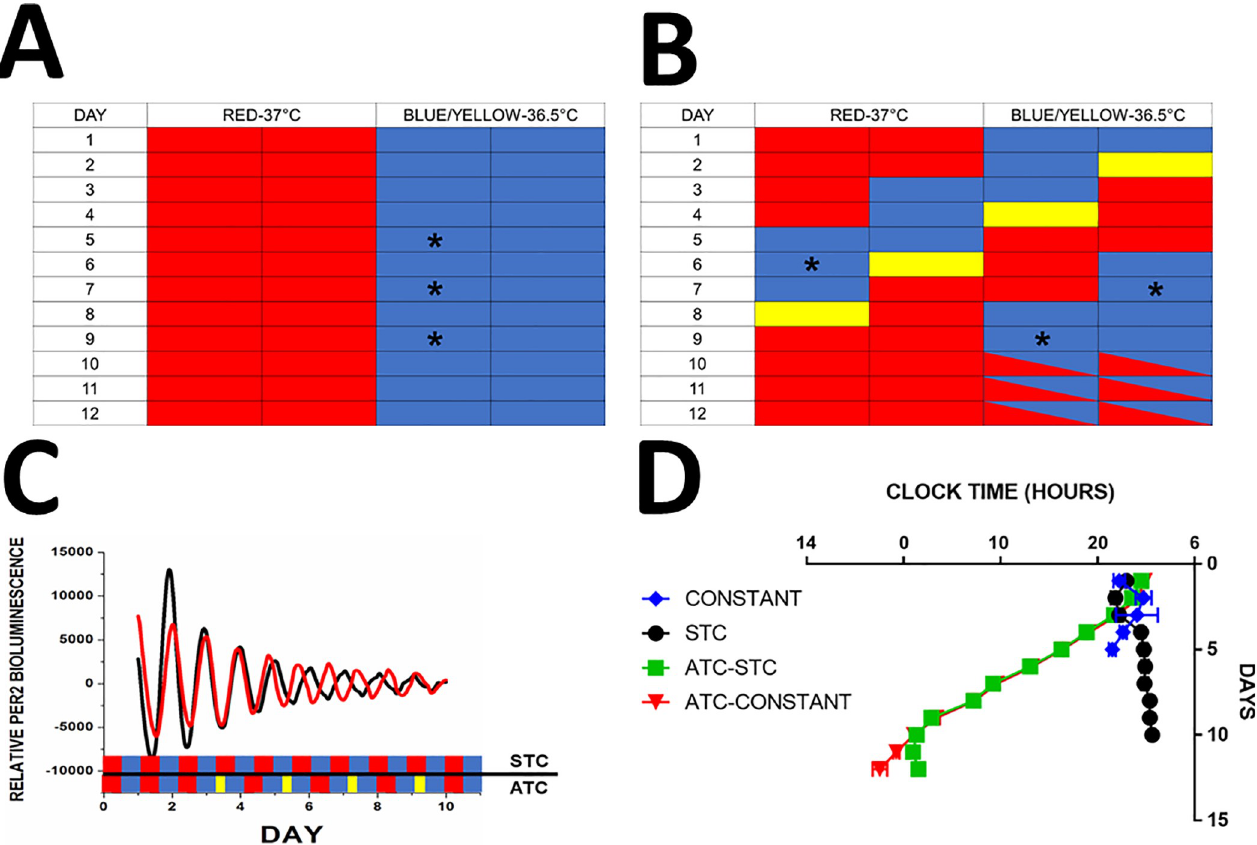
Fig 1. Temperature control of the splenic circadian clock. A: Schematic illustrating static temperature cycle. Each block represents 6 hours, red blocks are “high” temperature (37˚C) while blue bars are “low” temperature (36.5˚C). In experiments where immune challenge was performed, LPS was added 39 hours following the second, third, or fourth phase advance (ZT 3; Asterisks). B: Schematic illustrating advancing temperature cycle. Each block represents 6 hours, red blocks are “high” temperature (37˚C) while blue bars are “low” temperature (36.5˚C). Phase advances in the temperature cycle were accomplished by shortening the low temperature phase (yellow bars), advancing the subsequent cycle by 6 hours. Tissue was subjected to four consecutive 6-hour phase advances. In experiments where immune challenge was performed, LPS was added 39 hours following the second, third, or fourth phase advance (ZT3; Asterisks). For days 10, 11, and 12 boxes crossed with red and blue indicate where explants were either maintained in a STC or were released into constant temperature. C: Average Bioluminescence Traces. Traces showing relative Per2 bioluminescence traces for spleen explants under static temperature cycle (black; STC; n = 6) and advancing temperature cycle (ATC; red; n = 6). Temperature cycle indicated beneath traces; static temperature cycle by alternating red (high temp) and blue (low temp) bars, advancing with alternating red and blue bars supplemented with shorter yellow bars indicating shortened low temp period. D: Entrainment of Splenic Circadian Clocks by Temperature. Peak Per2 expression time plotted by day to demonstrate maintenance or shortening of circadian period under the following conditions: blue: kept in a constant 37˚C (CONSTANT; n = 6); black: kept in a static temperature cycle (STC; n = 6) 12:12 37˚C:36.5˚C; green: kept in an advancing temperature cycle, followed by a static temperature cycle on day 9 after 4 th shift (ATC-STC; n = 6); red: kept in an advancing temperature cycle, followed by release into constant 37˚C on day 9 after 4 th shift (ATC-CONSTANT; N = 6).